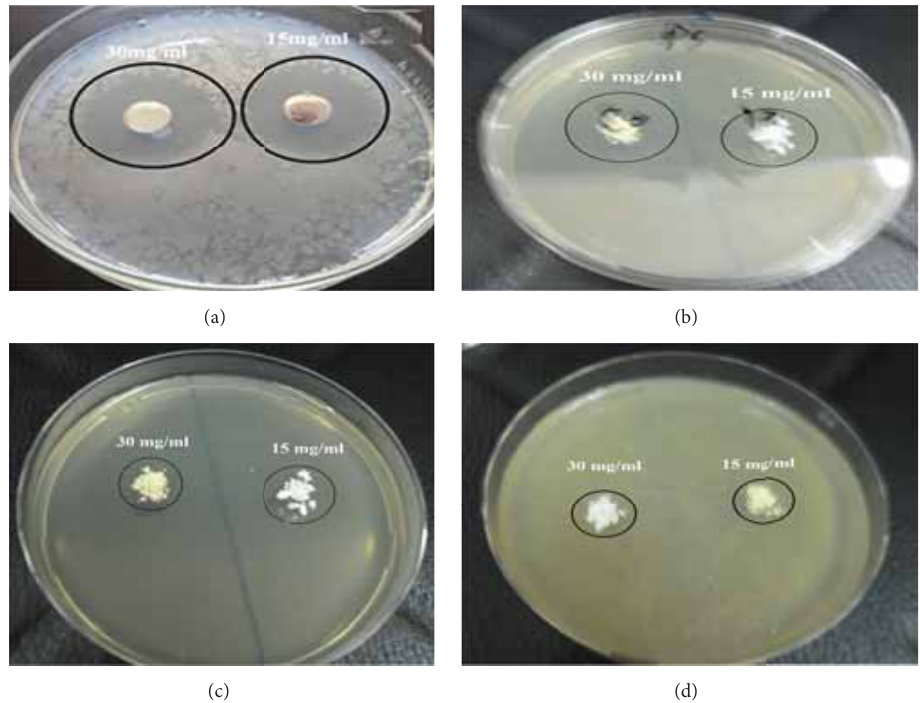
Figure 22: The influence of annealing process of zinc oxide on its antimicrobial activity against Pseudomonas aeruginosa using disc diffusion method. (a) As-prepared nanotube ZnO, (b) annealed ZnO at 500 ∘ C, (c) annealed ZnO at 700 ∘ C, and (d) annealed ZnO at 900 ∘